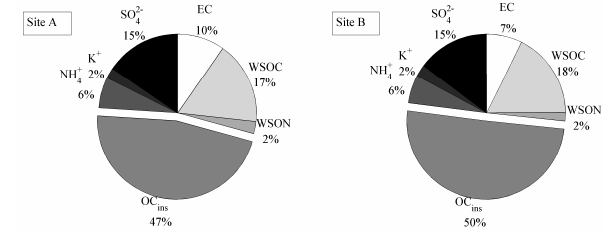
Figure 8: Comparison of measured elemental carbon, organic carbon (insoluble) , water soluble organic Fig. 8. Comparison of measured elemental carbon, organic car- carbon /nitrogen and ionic composition of PM2.5 at Site A(left) and Site B (right) during the pre- monsoon season. bon (insoluble), water soluble organic carbon /nitrogen and ionic composition of PM 2 . 5 at Site A(left) and Site B (right) during the pre-monsoon season.